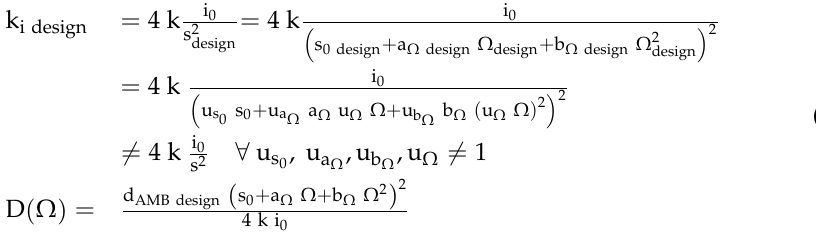
( a ) ( b ) Figure 11. Precession mode with DVFC for worst-case combination of all uncertainties: ( a ) eigenfrequency; ( b ) decay rate.